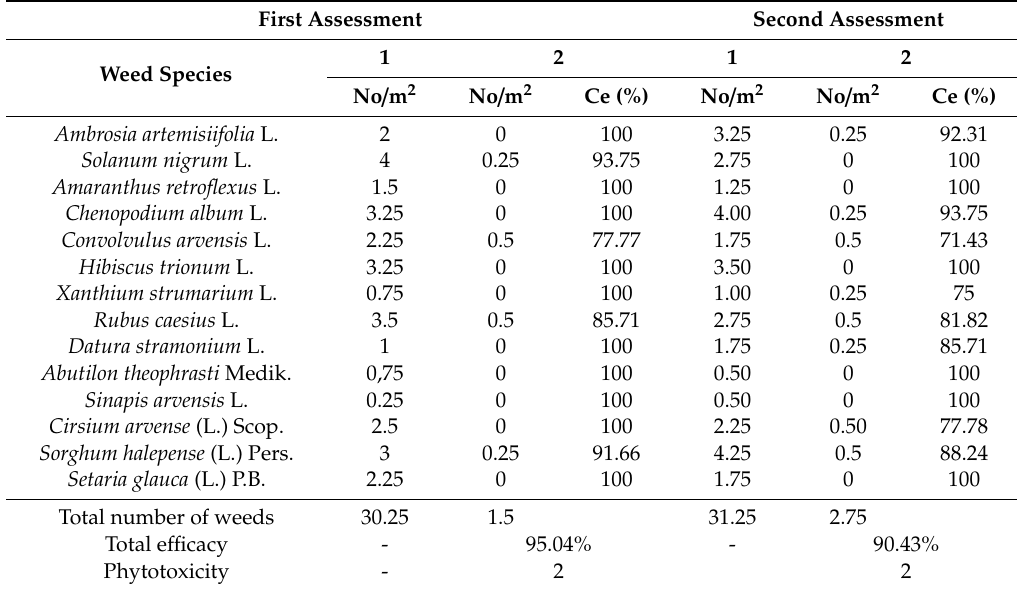
Table 4. E ffi cacy of used herbicides in soybean on the second